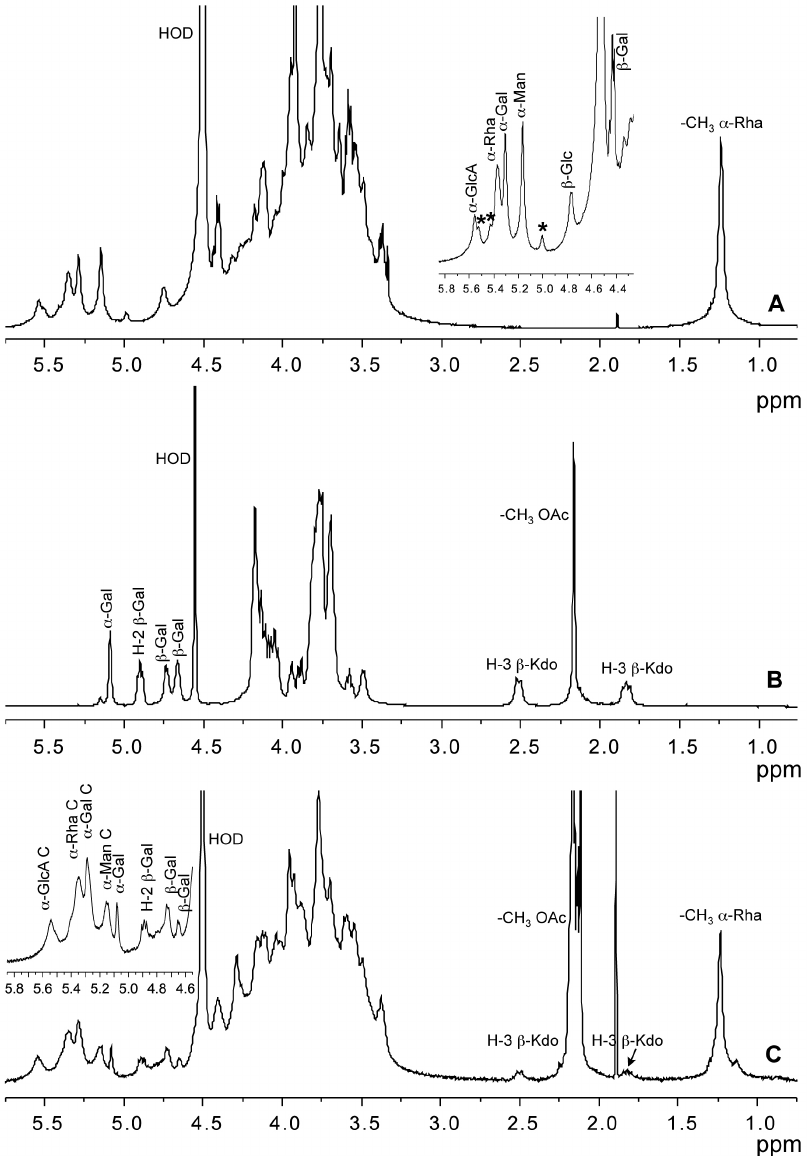
Figure 2. 1 H-NMR spectra of exopolysaccharides produced by BCC species. A) 1 H-NMR spectrum of de-acetylated CEP produced by B. pyrrocinia BTS7. The anomeric proton region is enlarged in the inset. Anomeric proton resonances of CEP are indicated, asterisks refer to signals of CO-CEP . B) 1 H NMR spectrum of GAL-KDO produced by B. cepacia BTS13 grown on YEM agar plates: anomeric proton resonances together with H- 2 of acetylated b -Gal and H-3 of Kdo are indicated. C) 1 H NMR spectrum of the CEP / GAL-KDO mixture produced by B. cenocepacia BTS2 grown